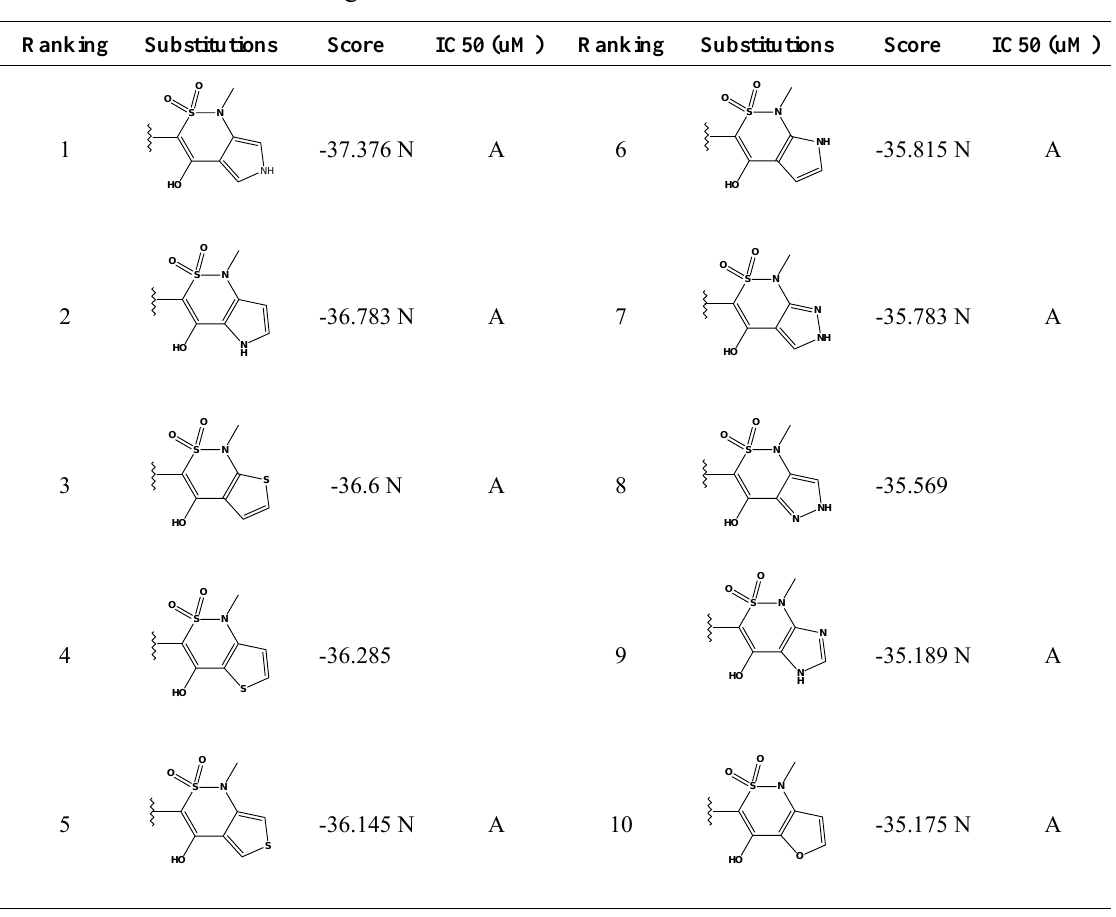
Table 5. Ten best scoring substitutions of Z1208 bund to JNK3 and their IC50